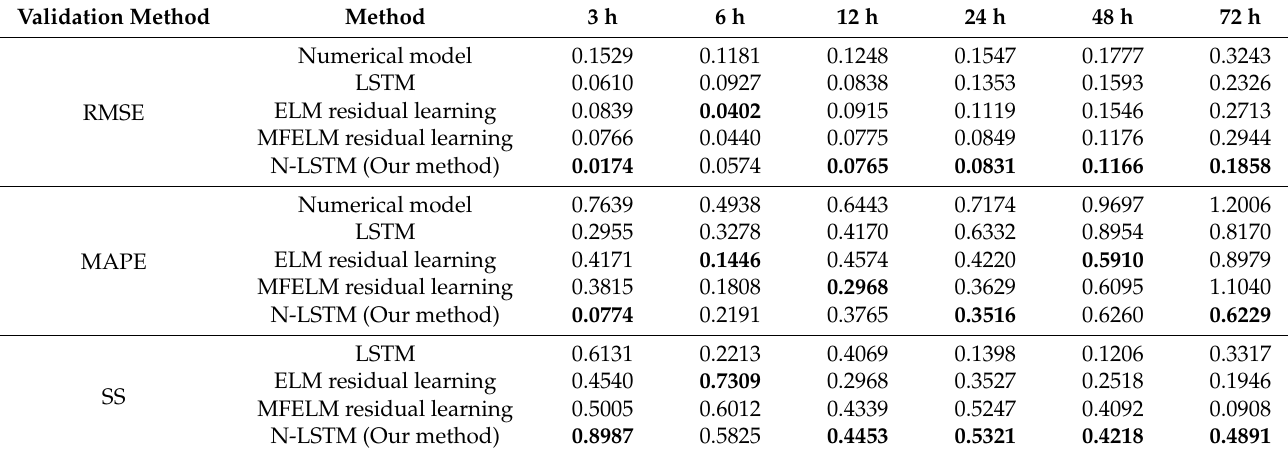
Table 2. Significant wave height prediction results for